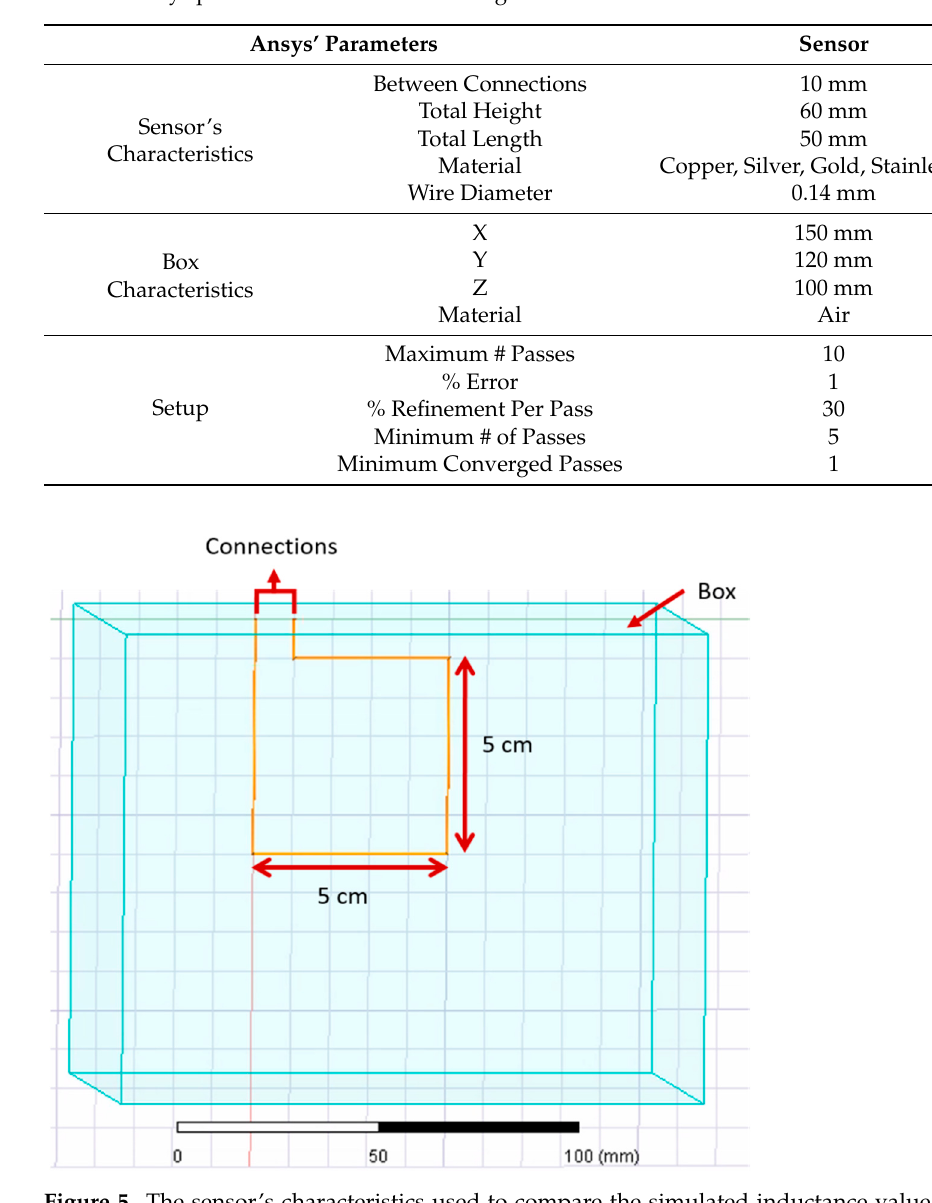
Table 3. Ansys parameters used for simulating inductance value for different materials.